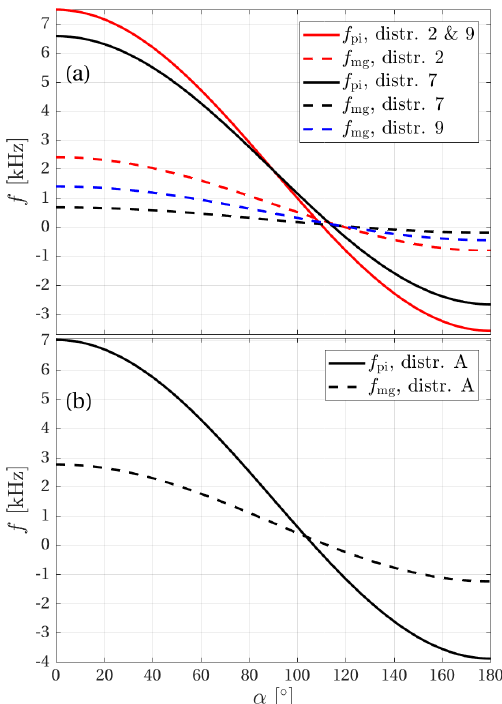
Figure 8. Doppler-shifted H 2 O + ion plasma frequencies, f pi , and frequencies of maximum growth, f mg , (a) at closest approach and (b) during the outbound motion of the spacecraft. The dispersion relations used to compute the Doppler shift correspond to distribu- tions 2, 7, 9, and A in Table